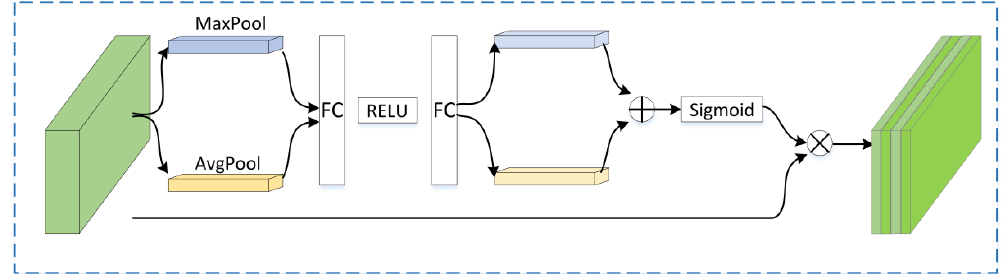
Figure 3. The structure of the channel attention module (CAM).